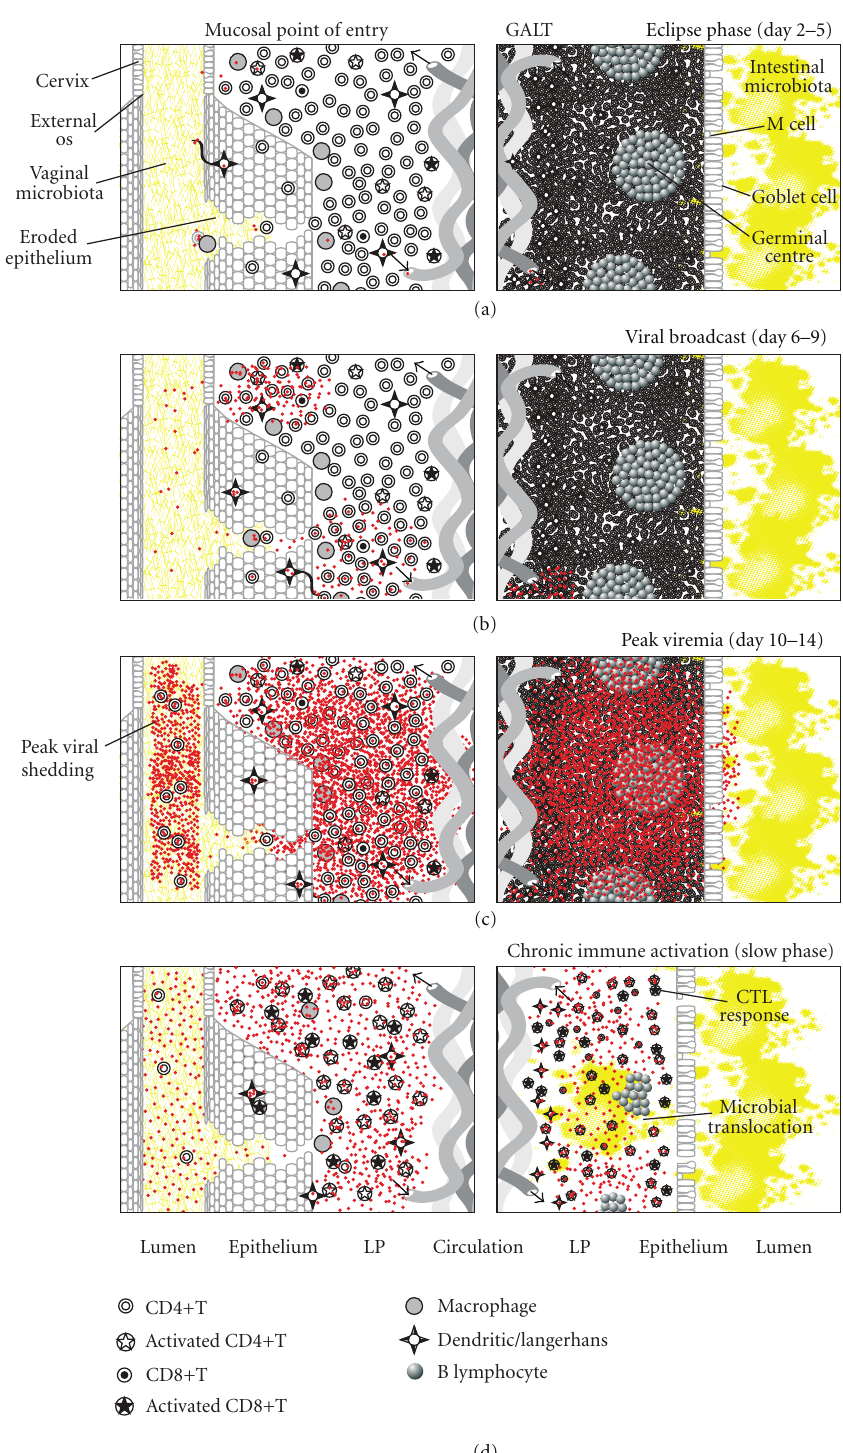
Figure 2: A mucosal catastrophe. Overview of the “fast phase” of HIV infection in the days following infection, including the eclipse phase (a), the viral broadcast phase (b), peak viremia (c), and subsequent chronic immune activation (d). See text for